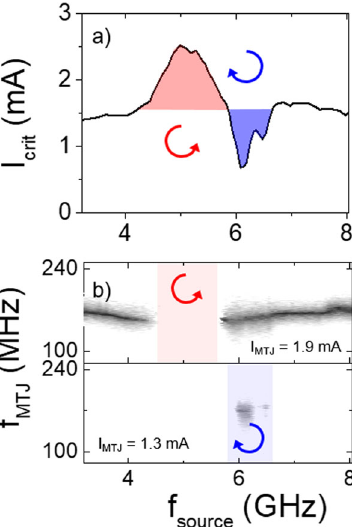
Fig. 7 Power dependence of the mode coupling. The measured power of the magnetic tunnel junction, MTJ, emission at the gyrotropic frequency, P f gyro , as a function of the rf excitation frequency, source , and power passed across the fi eld line antenna, P antenna rf , for a a sub-critical ( I MTJ = 5 mA) and b a super-critical dc current applied to the MTJ ( I MTJ = 8 mA) for an MTJ of diameter, d = 500 nm. The red and blue lines show the presence of modes with counter-clockwise (CCW) and clockwise (CW) sense of rotation of the spin-wave mode,